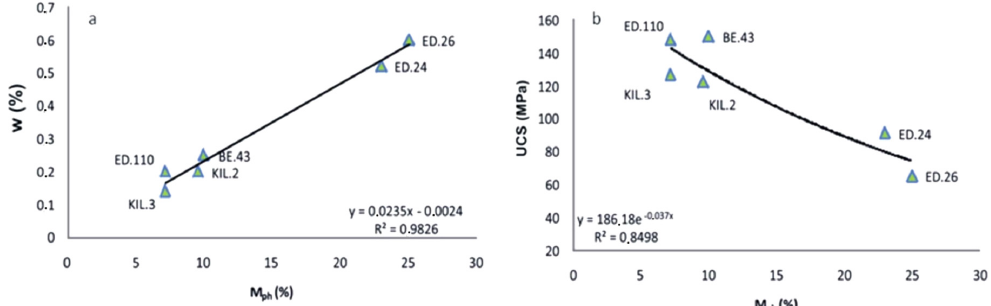
Figure 8. ( a ) The moisture content ( w (%)) versus the petrographic index ( M ph (%)) of the studied mafic rocks; ( b ) the uniaxial compressive strength test ( UCS (MPa)) versus the petrographic index ( M ph (%)) of the studied mafic rocks.